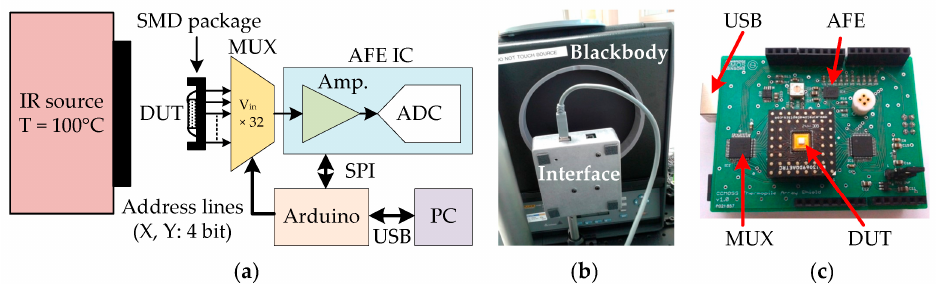
Figure 2. IR detector array: ( a ) Schematic; ( b ) Characterization setup; and ( c ) Circuit board